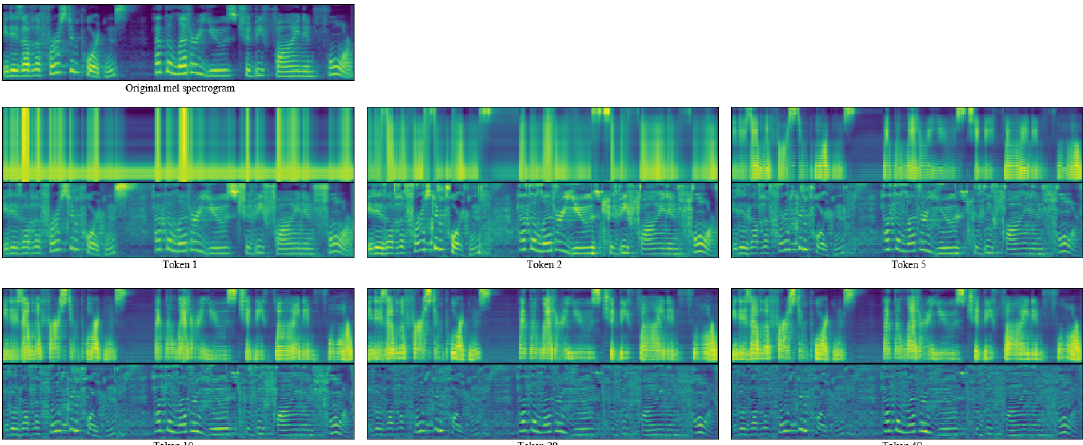
Figure 10. The estimated mel spectrogram and corresponding estimated residual with different heads number n